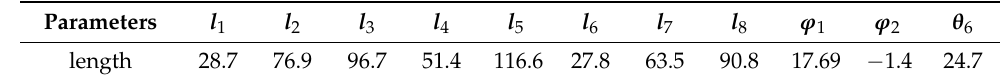
Table 2. Optimization results.